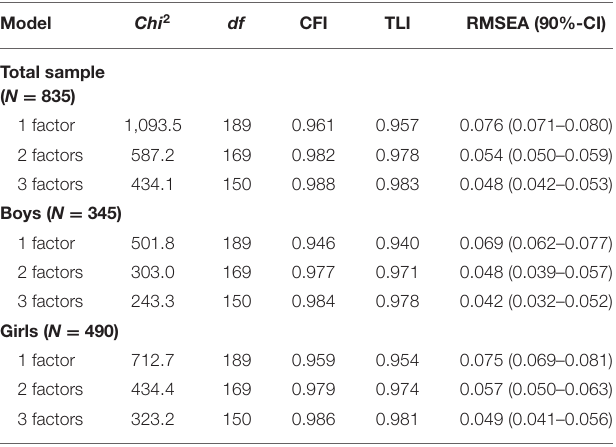
TABLE 3 | Fit indices for exploratory factor analyses with 1–3 factors for the total sample and according to gender.